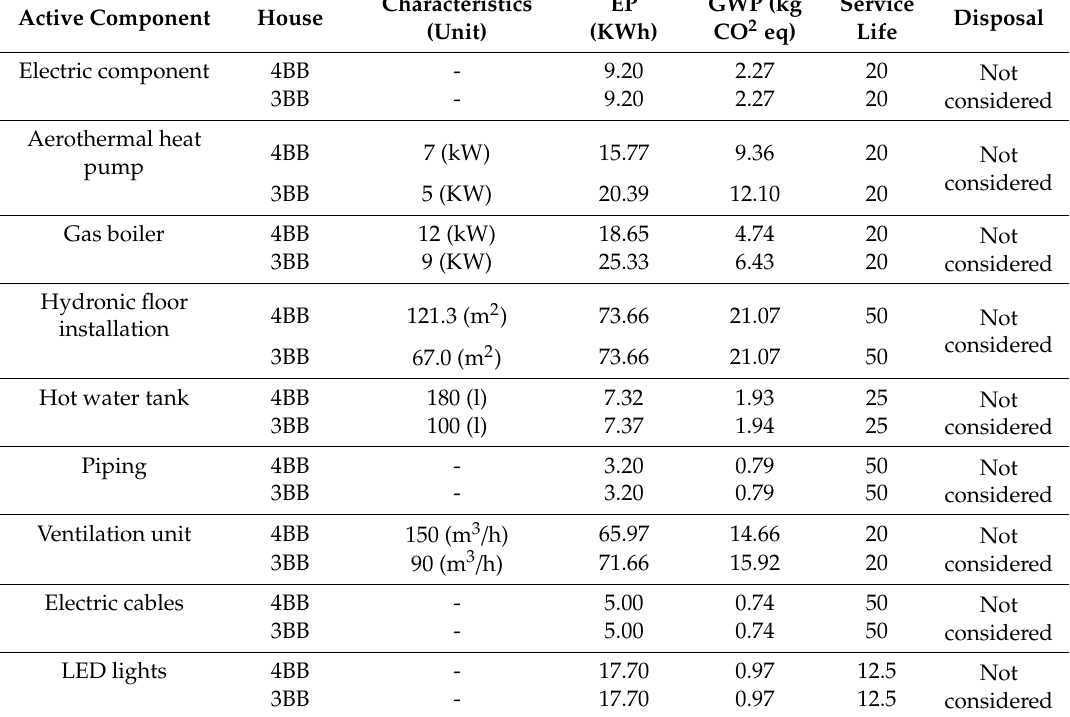
Table 4. Data on the active components of buildings, including information on primary energy (EP), Global Warming Potential (GWP) and service